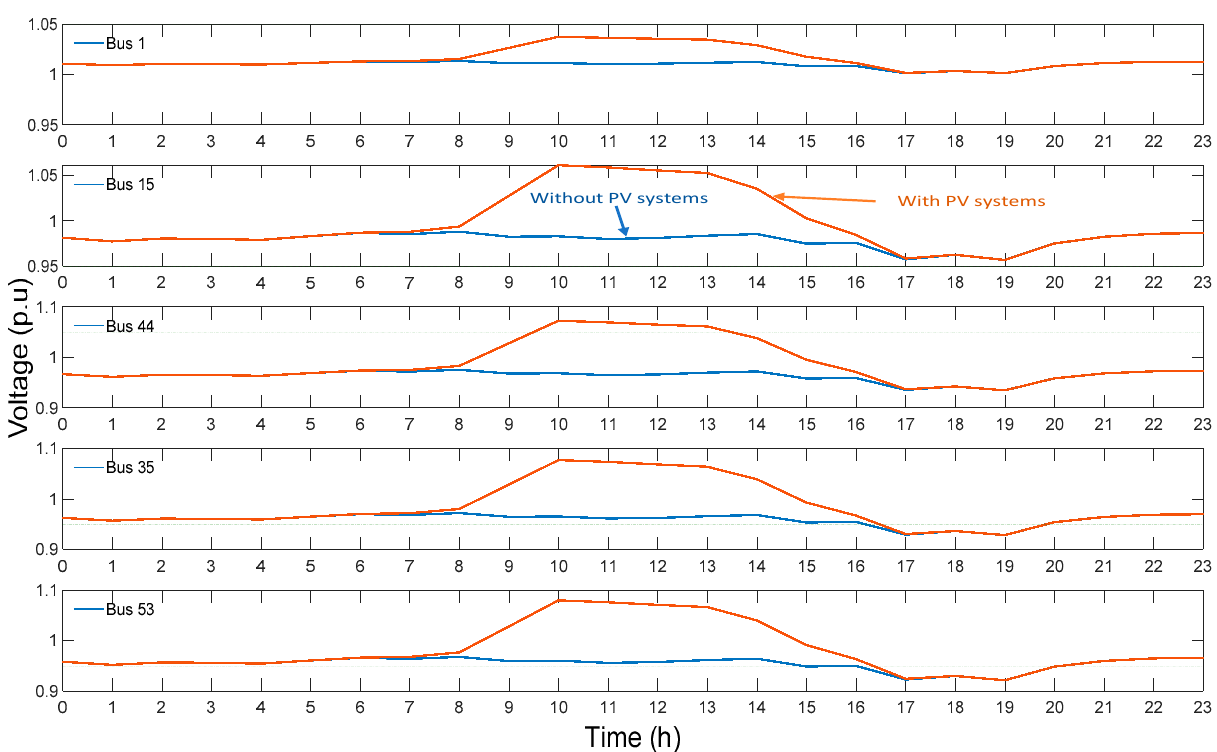
Figure 6. Network daily voltage profile with and without PV system at different load buses.